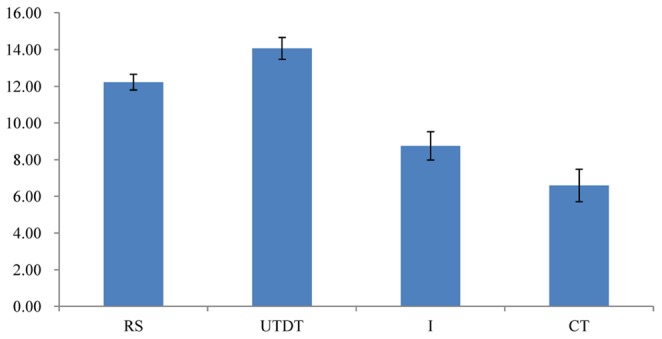
The mean of the differential attitude scores in different thinking modes in Experiment 3. Higher scores indicate larger attitude scores. The error bars indicate the SE of the differential attitude scores.